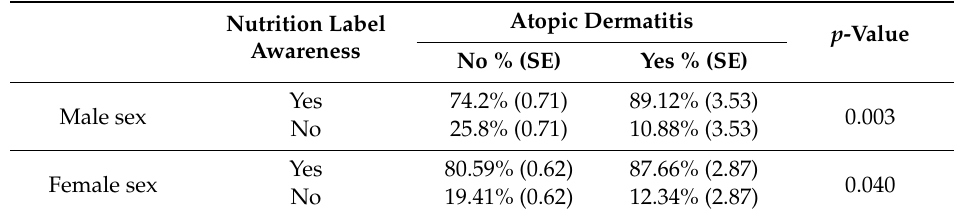
Table 2. Di ff erences in the prevalence of atopic dermatitis according to nutrition label awareness and sex. Nutrition Label